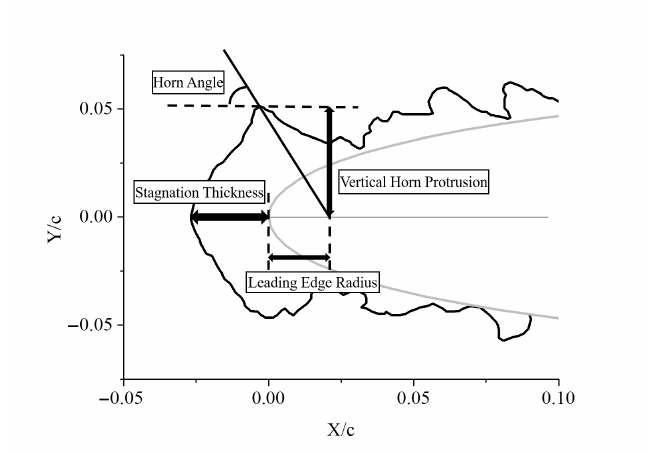
Figure 4. Ice shape characterization metrics.